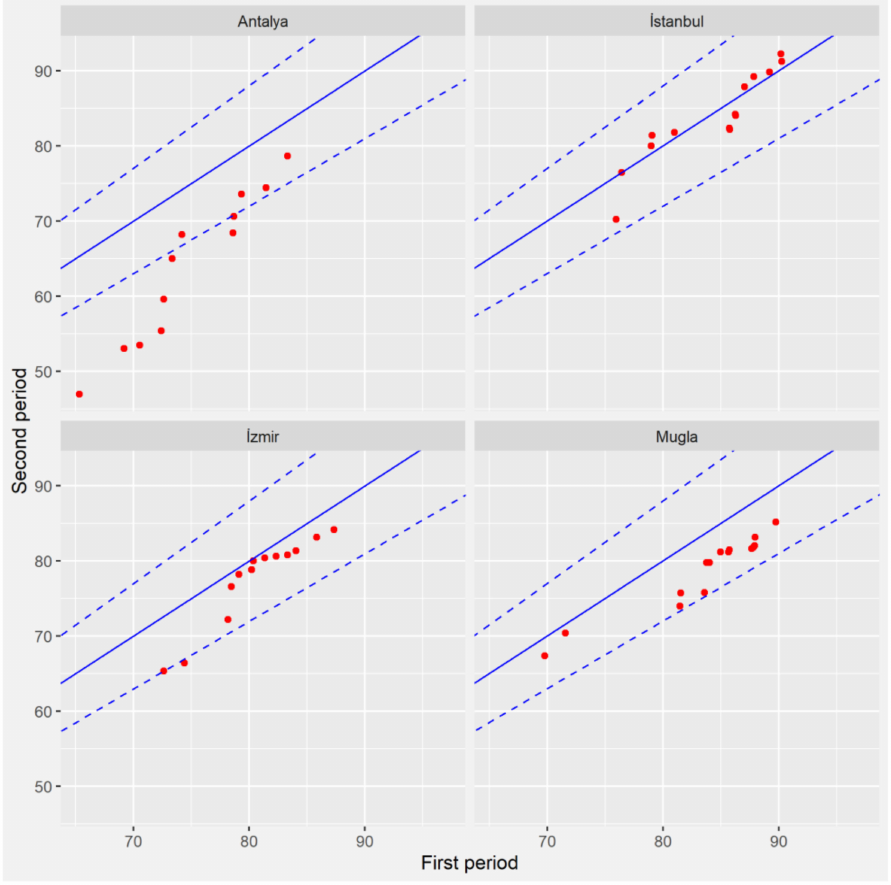
Figure 14. Sen trend analysis of TCI of